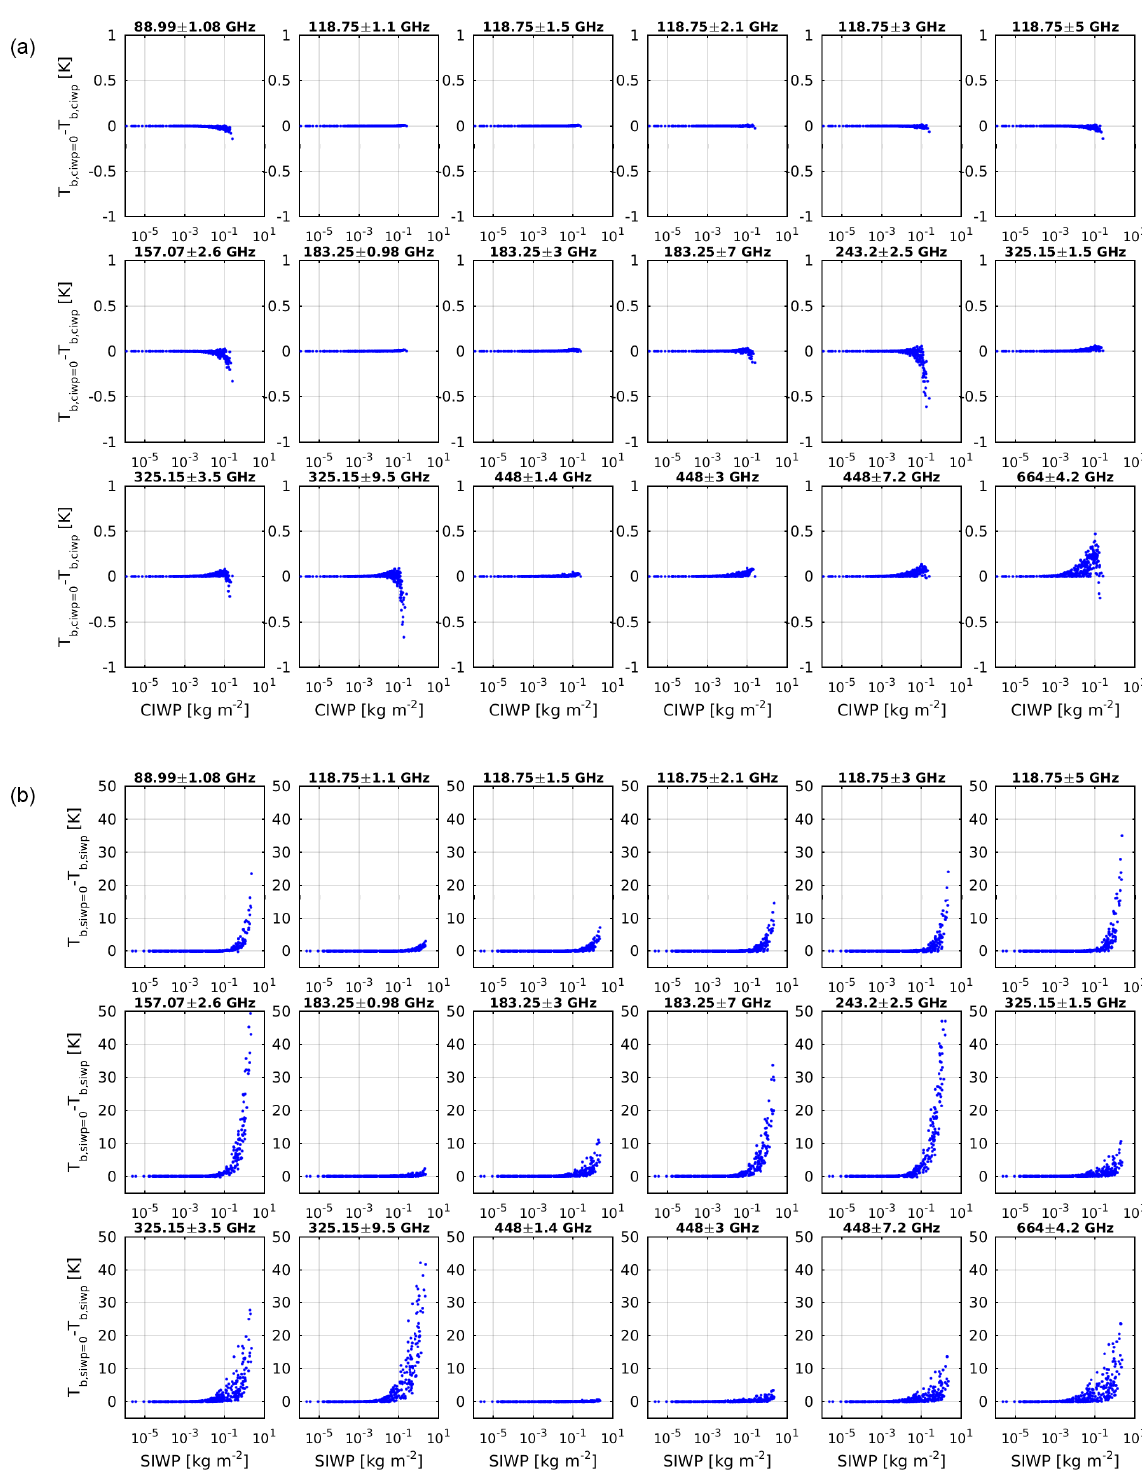
Figure 3. Difference in brightness temperatures between simulations with (a) cloud ice set to zero and with simulation with unchanged cloud ice as a function of the CIWP and (b) same as for panel (a) but with snow set to zero and as a function of